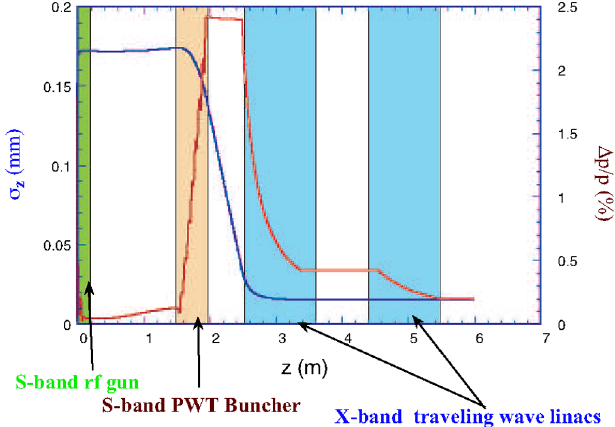
FIG. 1. (Color) HOMDYN simulation of the rms bunch length and relative momentum spread for a 10 pC case, optimized for laser acceleration experiments at the ORION photoinjector. The rms bunch length, plotted in blue, begins to decrease inside of the S -band buncher and continues though the drift space, finally reaching a minimum value of 20 (cid:4) m inside of the first X -band linac section. In contrast, the relative, rms momentum spread, plotted in red, increases sharply in the buncher and is subse- quently decreased by acceleration in the two X -band sections to a final value of